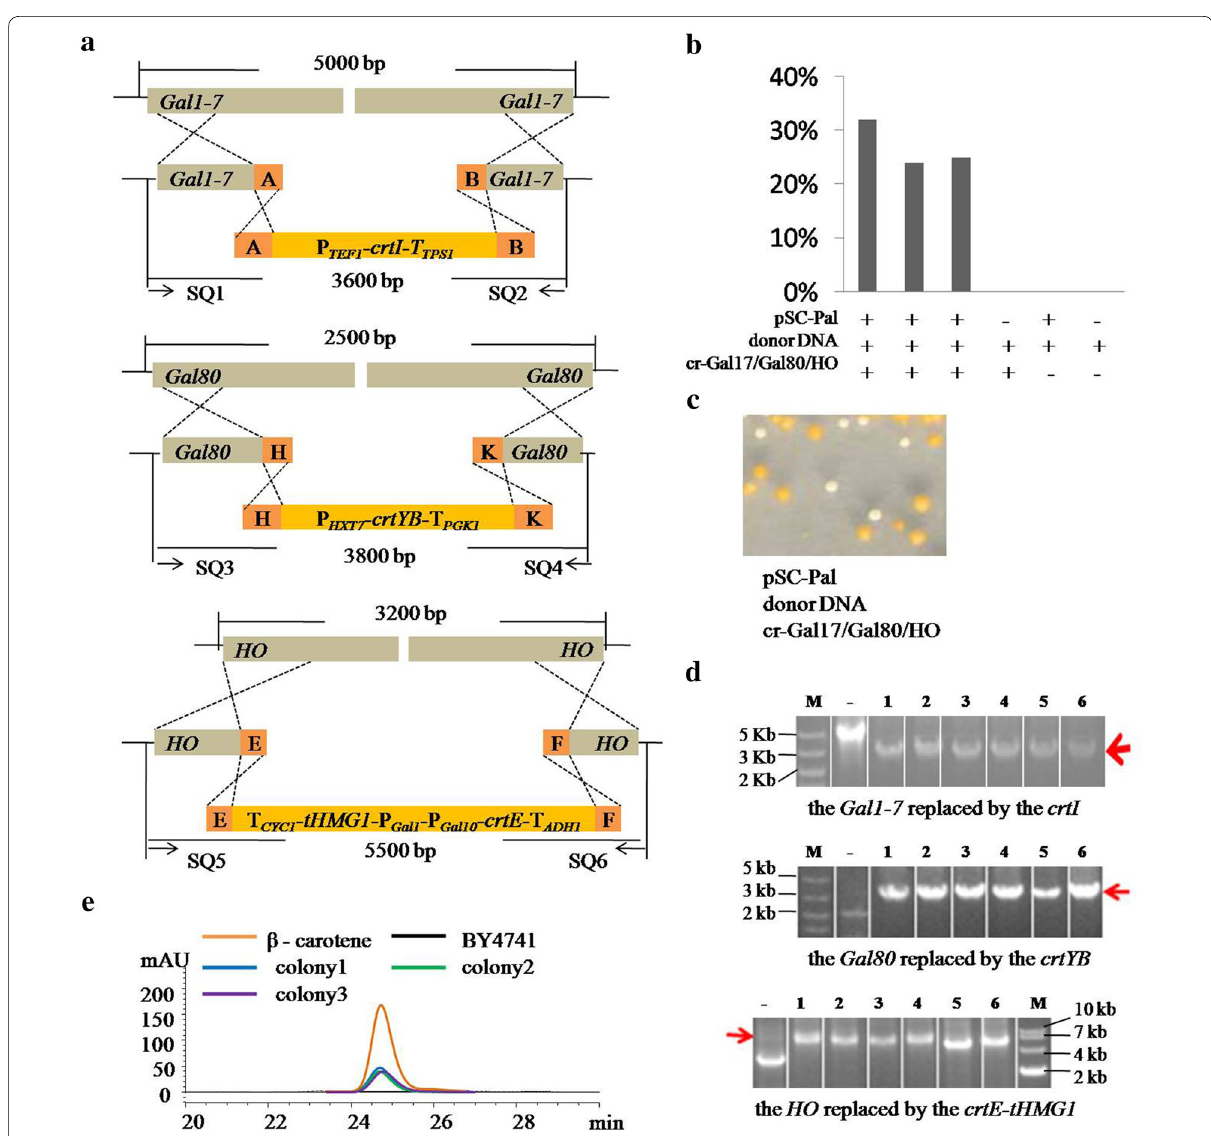
Fig. 4 scCRISPR/Cpf1 facilitated tripleplex genomic integration of in vivo assembled DNA parts in S. cerevisiae . a scCRISPR/Cpf1 facilitated tripleplex genomic integration of β‑carotene synthetic pathway of the crtI , crtYB , and tHMG1 ‑ crtE into the target sites Gal1 ‑ 7 , Gal80 , and HO , respectively. b Efficiency of tripleplex genomic integration assisted by scCRISPR/Cpf1. c Pictures of transformants obtained by co‑transforming donor DNA of β‑carotene synthetic pathway with pSC‑Pal and cr‑Gal17/Gal80/HO. d PCR result of 1 white transformant ( ) and 6 orange transformants (1–6) − using primer pairs SQ1/SQ2, SQ3/SQ4, and SQ5/SQ6 for integration of crtI at the Gal1 ‑ 7 (up), crtYB at the Gal80 (middle), and tHMG1 ‑ crtE at the HO (bottom), respectively. The horizontal red arrows indicate the PCR bands of correct integration. M: DNA Ladder 5000 or DNA Ladder 10,000. e HPLC analyses of β‑carotene synthesis to evaluate the tripleplex genomic integration. β‑carotene: β‑carotene standard; BY4741: starting yeast strain; Colony1, Colony2, and Colony3: three orange colonies randomly selected. A, B, E, F, H, and K in orange rectangle: 50 bp homologous connector sequences. P TEF1 , P HXT7 , P Gal1 , and P Gal10 : promoters of the TEF1 , HXT7 , Gal1 , and Gal10 , respectively; T TPS1 , T PGK1 , T CYC1 , and T ADH1 : terminators of the TPS1 , PGK1 , CYC1 , and ADH1 ,